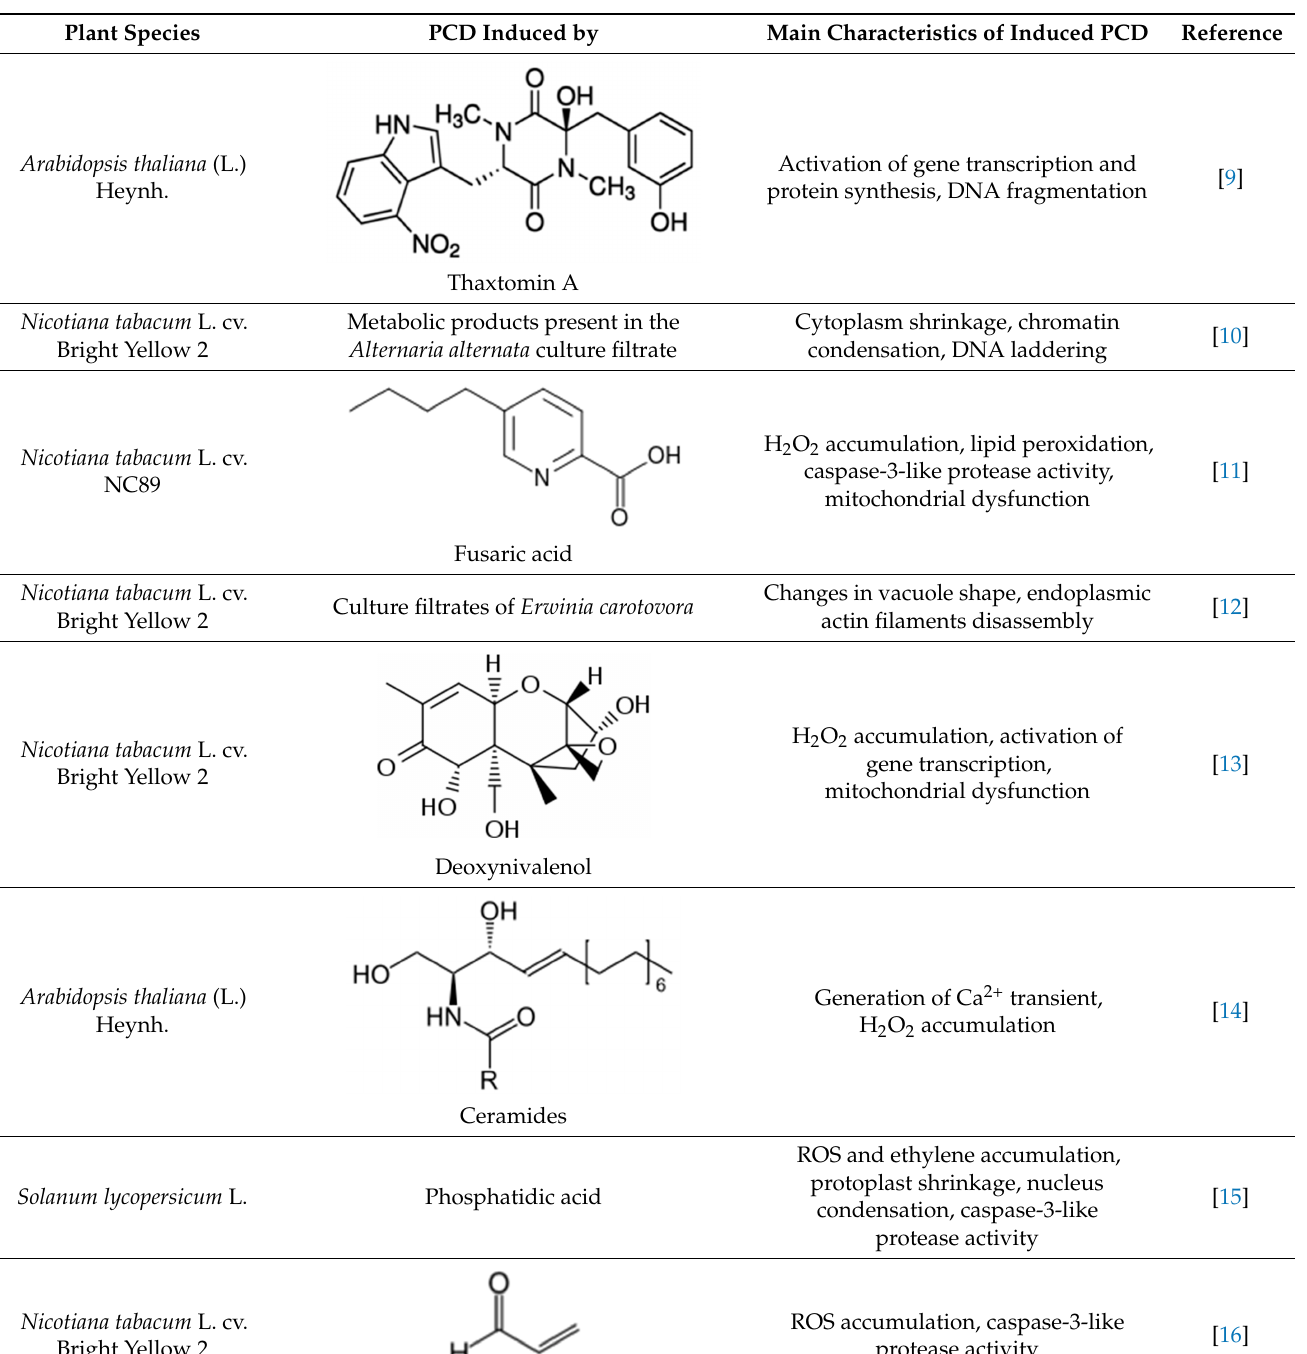
Nicotiana tabacum L. cv. Bright Yellow 2